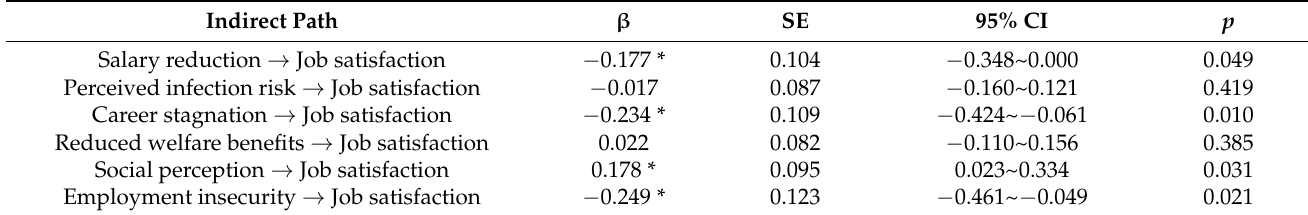
Table 9. Indirect effects analysis